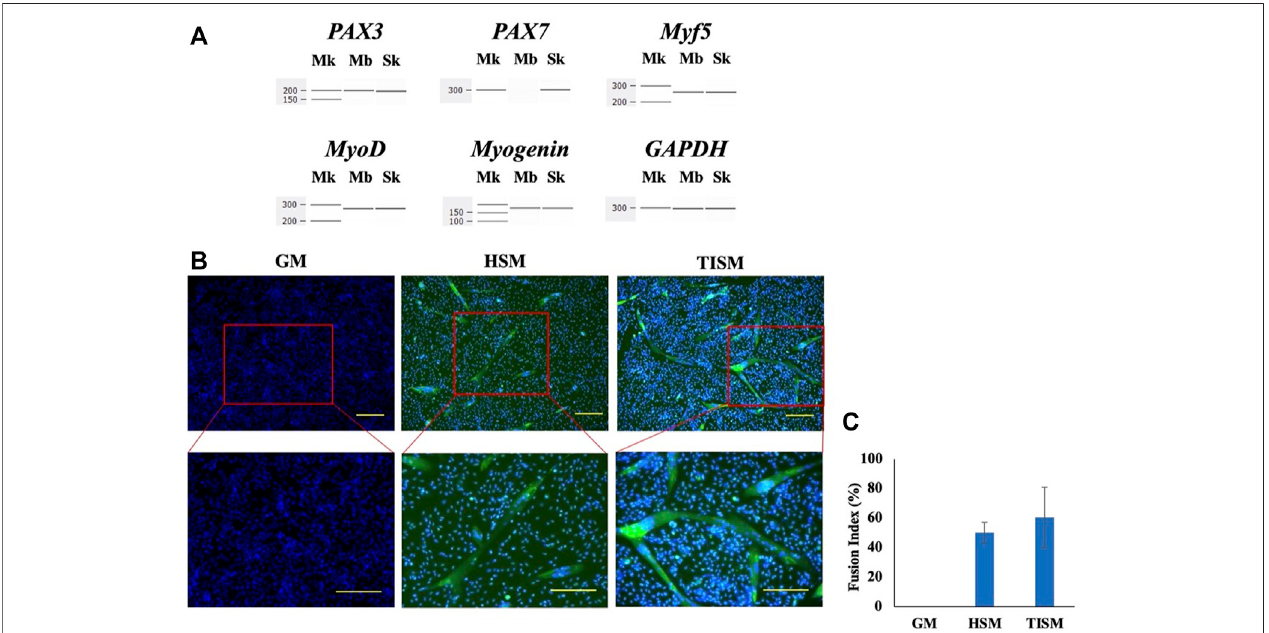
FIGURE 1 | Characterization of human immortalied myoblasts. (A) . Expression of myogenic genes. The mRNA levels of the PAX3, PAX7, Myf5, MyoD , and myogenin genes in human immortalized myoblasts were assessed by RT-PCR using GAPDH mRNA as a control. Electropherograms of the ampli fi ed products are shown with size markers on the left (Mk). All ampli fi cations except that of PAX7 resulted in a band at the expected size (Mb) as ampli fi ed products from skeletal muscles (Sk). (B) . Differentiation of human immortalized myoblasts. Human immortalized myoblasts were cultured in two types of differentiation (HSM and TISM) and one type of growth (GM) media for 10 days and analyzed. Merged results of immunostaining of myosin heavy chain and Hoechst 33342 staining are shown. In differentiated cells, spindle-shaped and multinuclear cells were observed microscopically (HSM, TISM), whereas they were not observed in the cells cultured in growth medium (GM). Myosin heavy chain signals were observed as green signals in the cells cultured in differentiation medium (TISM, HSM) but not in the cells in growth medium (GM). Squaresmarkedbyred linesintheupper panelswereenlargedand areshown inthelowerpanels.Scale bars=100 μ m. (C) .Thefusion index. Thefusionindex(%)was calculated for each medium and is shown as